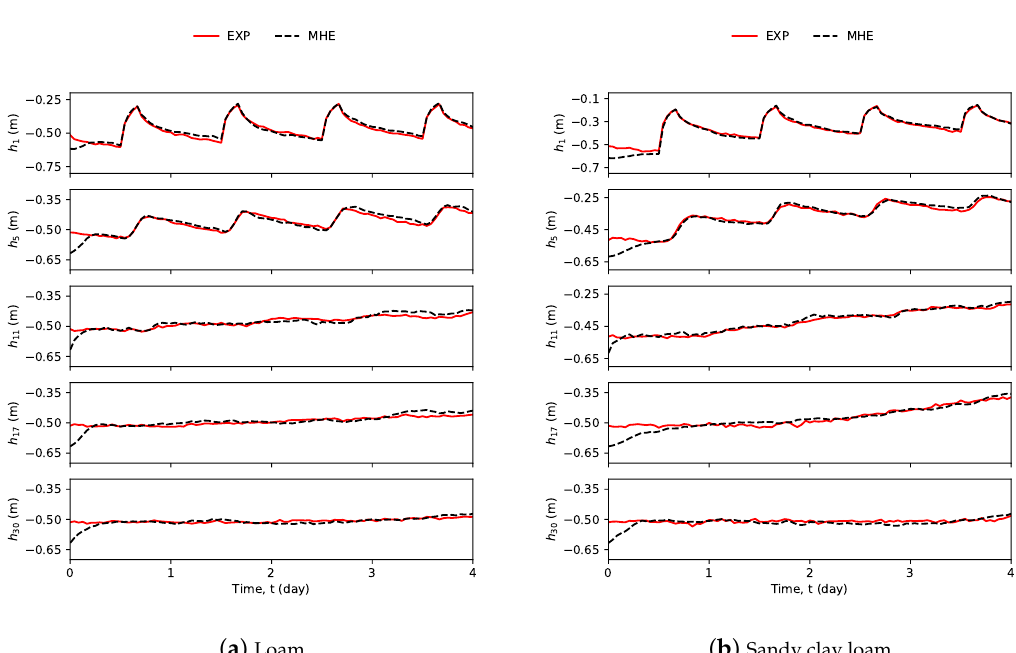
Figure 5. Selected trajectories of the process states and estimated states using DeMHE.